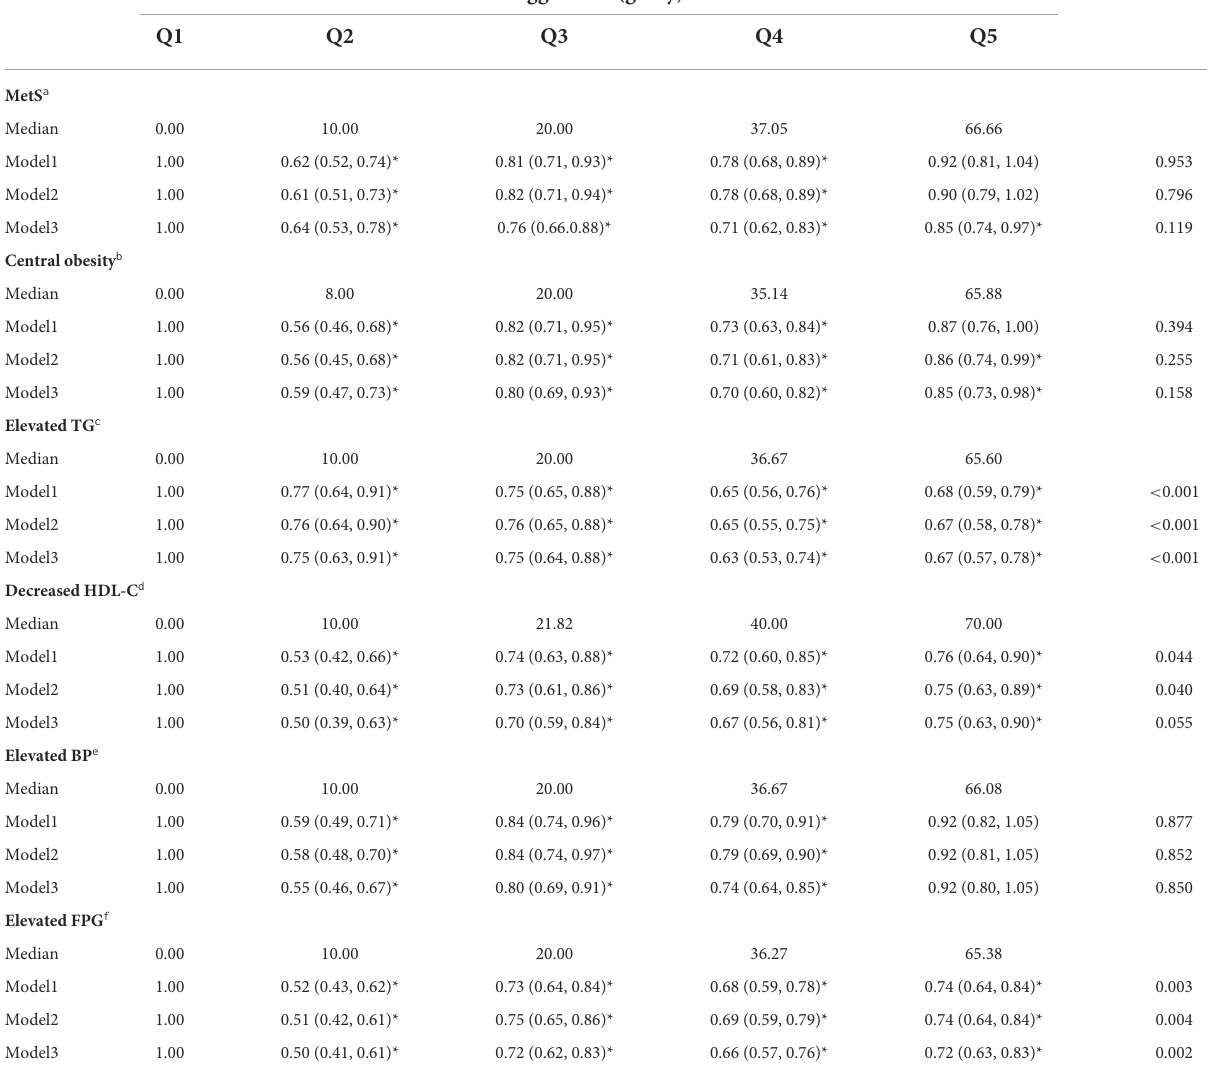
TABLE 2 Hazard ratio (HR) and 95% confidence interval (CI) for association of egg intake with